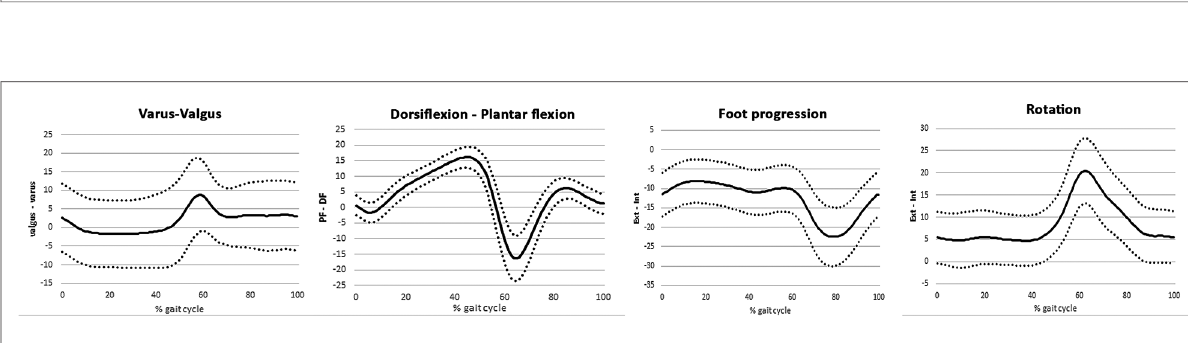
foot progression, whilst hip internal rotation was associated with internal foot progression. However, other studies concluded that gender had no effect on ankle kinematics without considering the foot progression (11, 16 – 18).